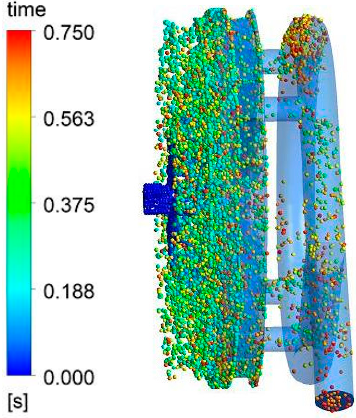
Figure 7. The movement track of particles.